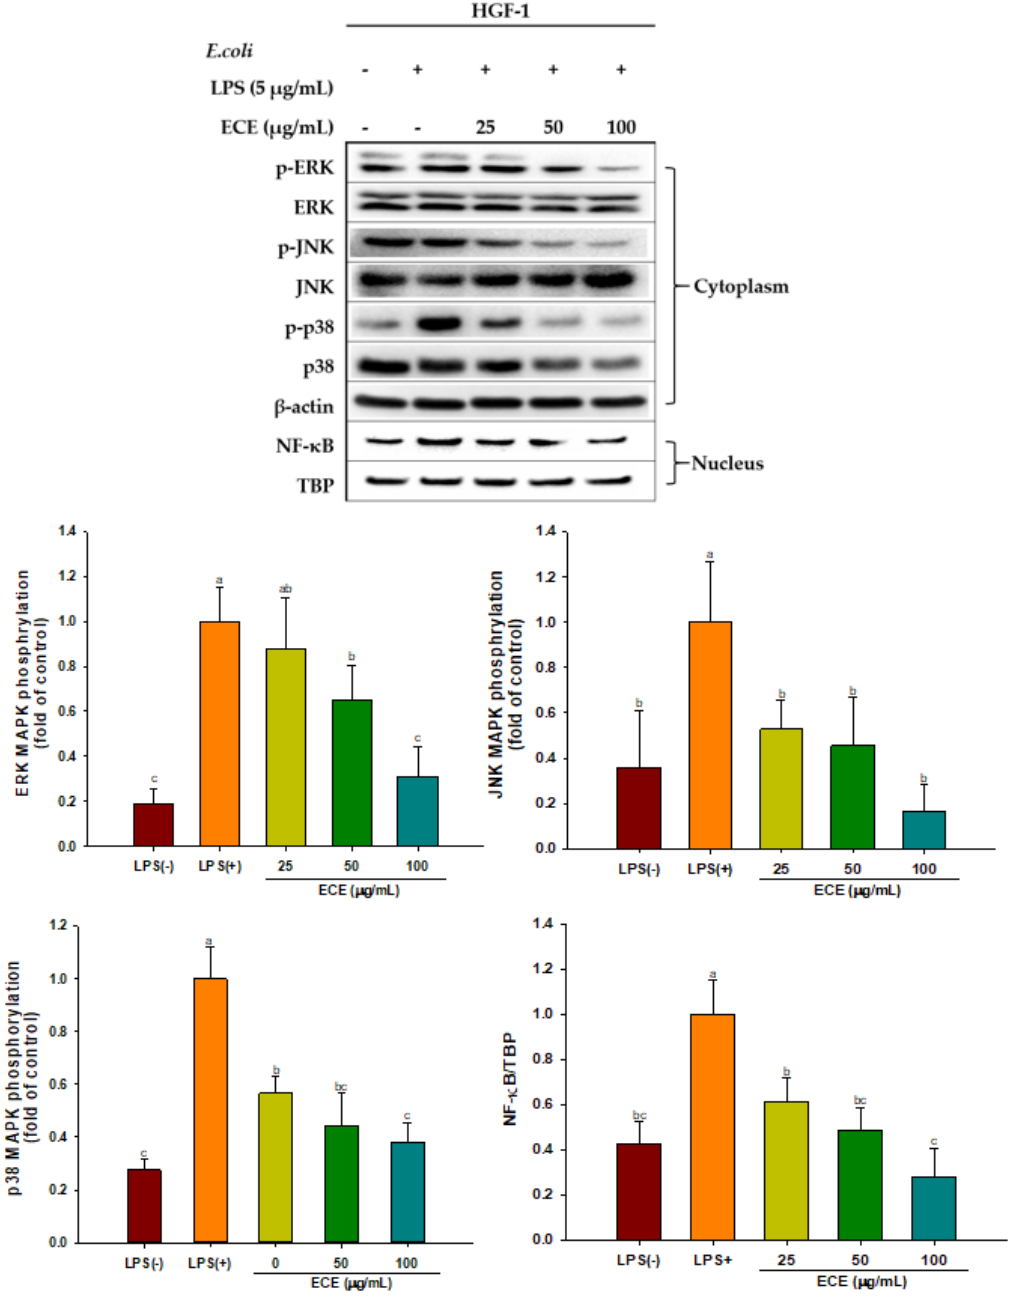
Figure 4. Effect of ECE on protein expression associated with MAPK and nuclear NF- κ B in LPS-stimulated HGF-1 cells. Different letters (a–c) show significant difference ( p < 0.05). ECE: Ecklonia cava extract; LPS: lipopolysaccharide; HGF: human gingival fibroblasts. ERK: extracellular signal-regulated kinase; JNK: c-Jun N-terminal kinase; MAPK: mitogen-activated protein kinase; NF- κ B: nuclear factor-kappa B; TBP: TATA-binding protein.